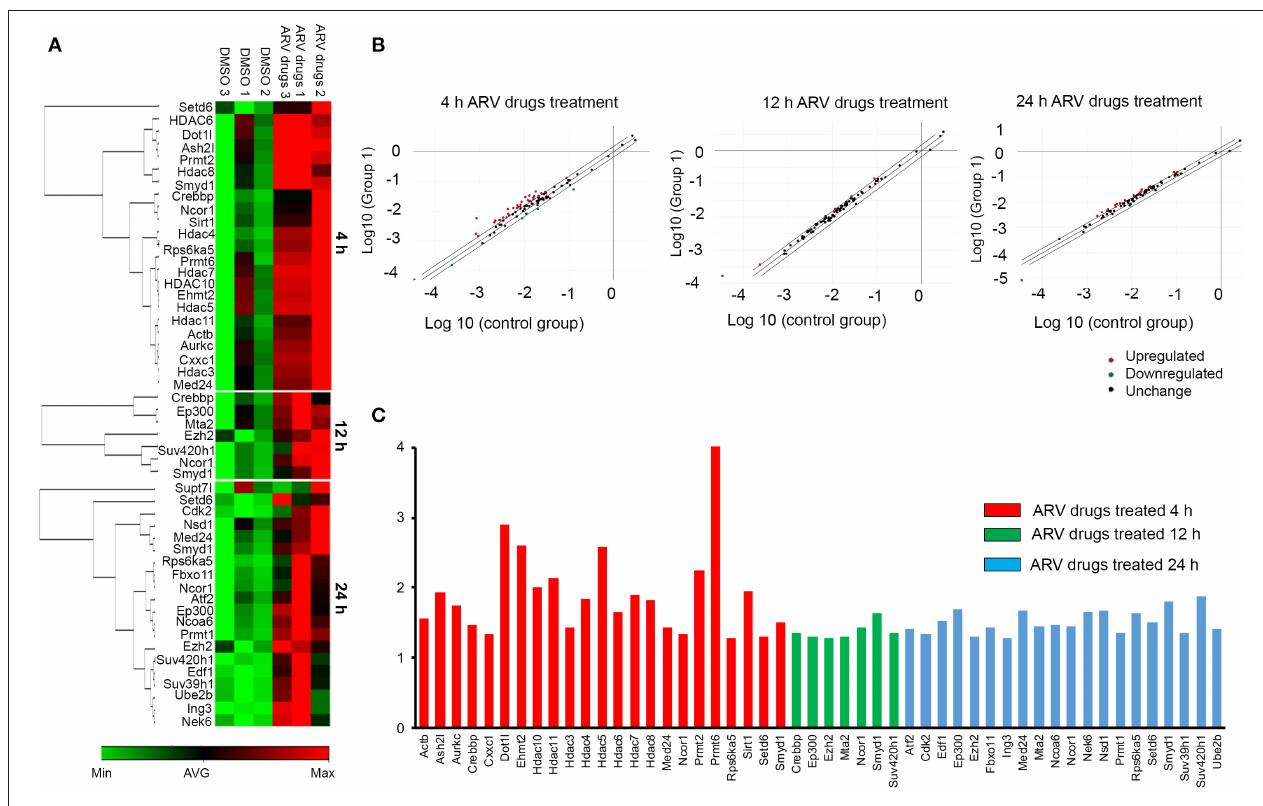
FIGURE 3 | ARV drugs treatment modulates expression of epigenetic regulating enzyme. NRVCs were treated with ARV drugs (5 µ M of Ritonavir, Abacavir, Atazanavir, and Lamivudine) for 4, 12, and 24h and expression of epigenetic enzyme was measured by RT 2 PCR array profiling. (A) Clustergram showing differentially expressed genes ( p < 0.05, Fold Change > 1.2) obtained on RT 2 PCR array profiling, green represent minimum and red represent maximum magnitude of expression. (B) Scatter Plot representing normalized expression of genes between 4, 12, and 24h ARV drugs treated vs. control group. Central diagonal line represents no change, whereas, outer diagonal lines indicate the fold regulation threshold ( > 1.2). Genes with data points beyond the outer lines in the upper left and lower right corners are up-regulated or down-regulated, respectively. (C) Graphical representation of differentially expressed chromatin modifying enzymes against expression regulation on drug treatment at 4h (red), 12h (green), and 24h